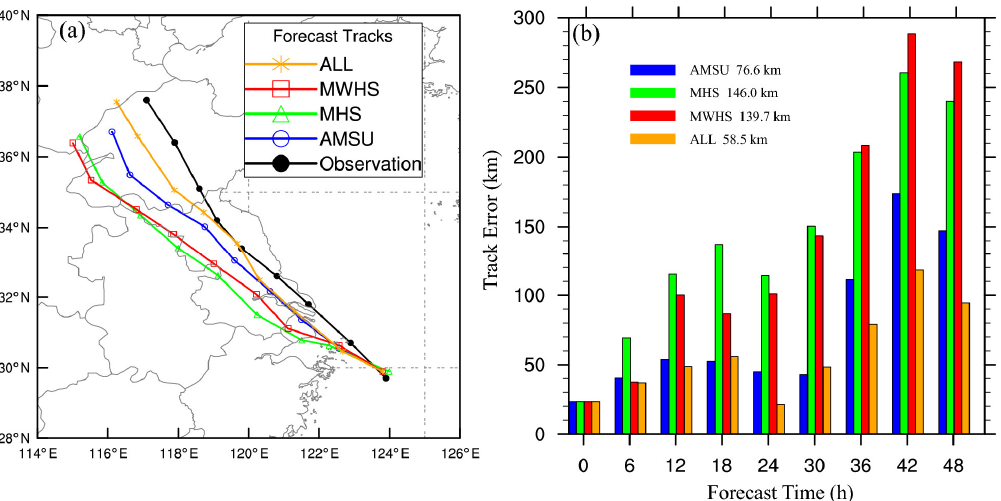
Figure 13. ( a ) The track and ( b ) the track error (km) of Typhoon Ampil in the 48-h forecast initialized at 1800UTC on 21 July 2018.